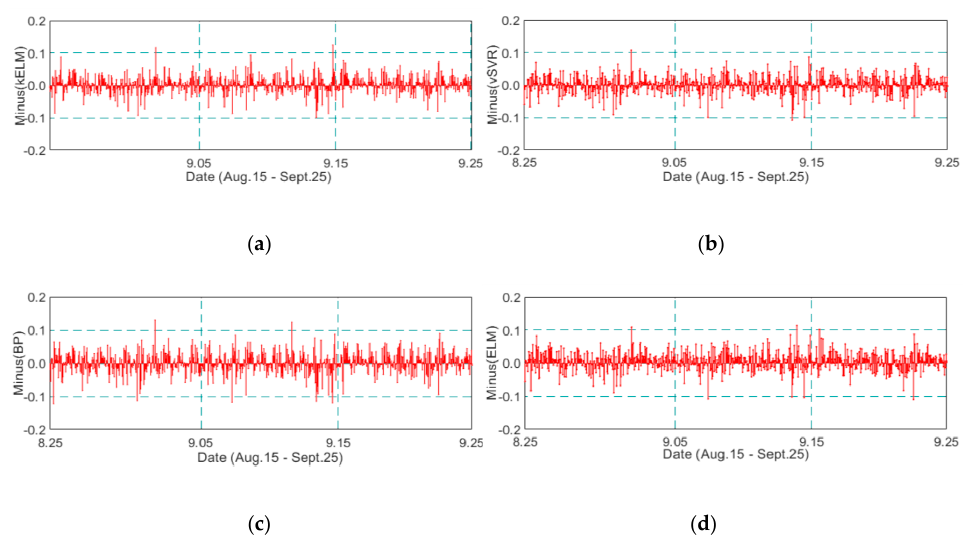
Figure 9. The predicted values of each regression algorithm minus the actual values. ( a ) kELM, ( b ) v SVR, ( c ) ELM, ( d )